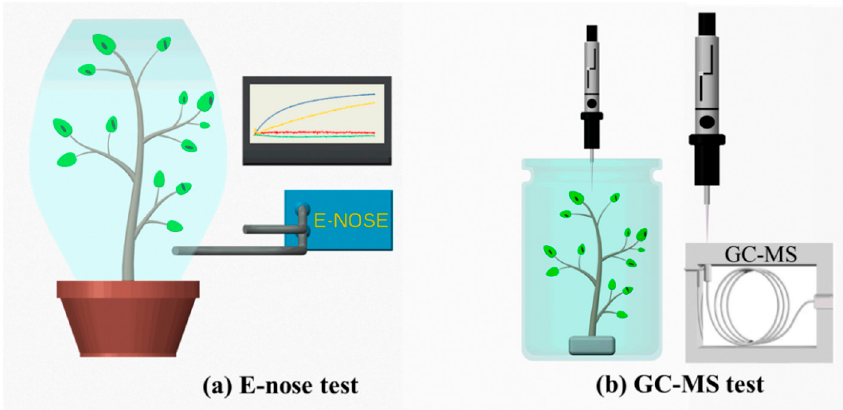
Figure 1. Illustration of early diagnosis of aphids-stressed tomato plants by using E-nose and GC-MS .